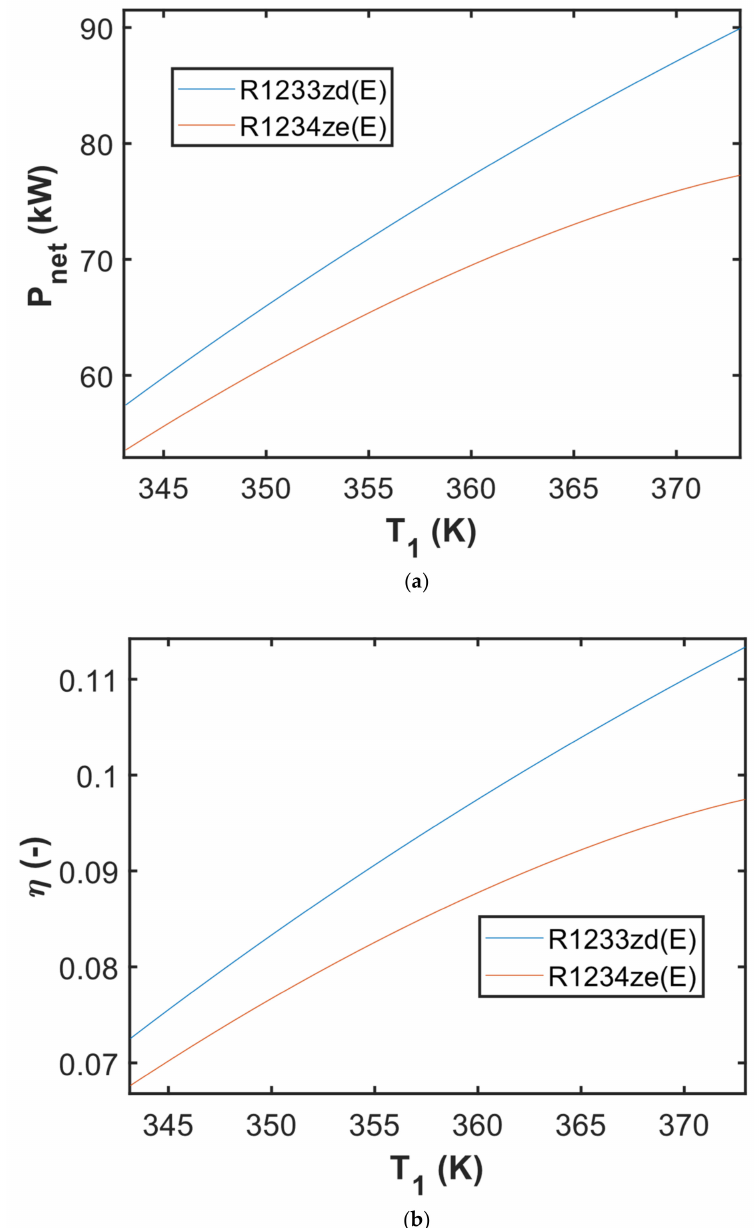
Figure 6. The obtained result of ( a ) net output power in the P net —T 1 diagram; ( b ) ORC efficiency in the η —T 1 diagram simulated with the ∆ T 1 = 1